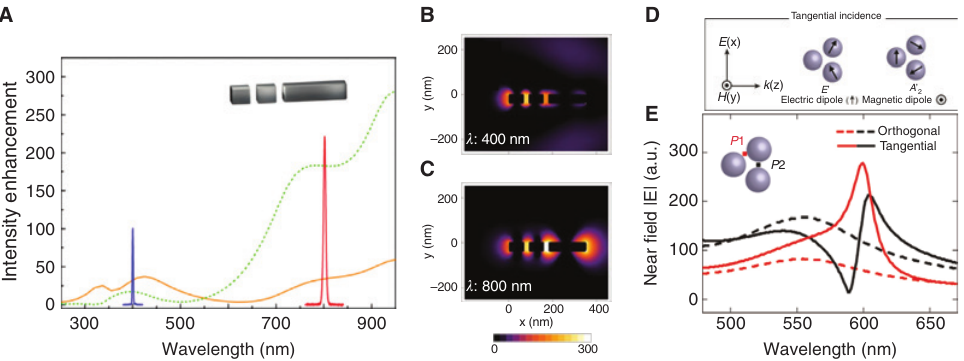
Figure 5: Two examples of multiresonant plasmonic systems based on the optical coupling between localized plasmonic modes in in-plane trimer